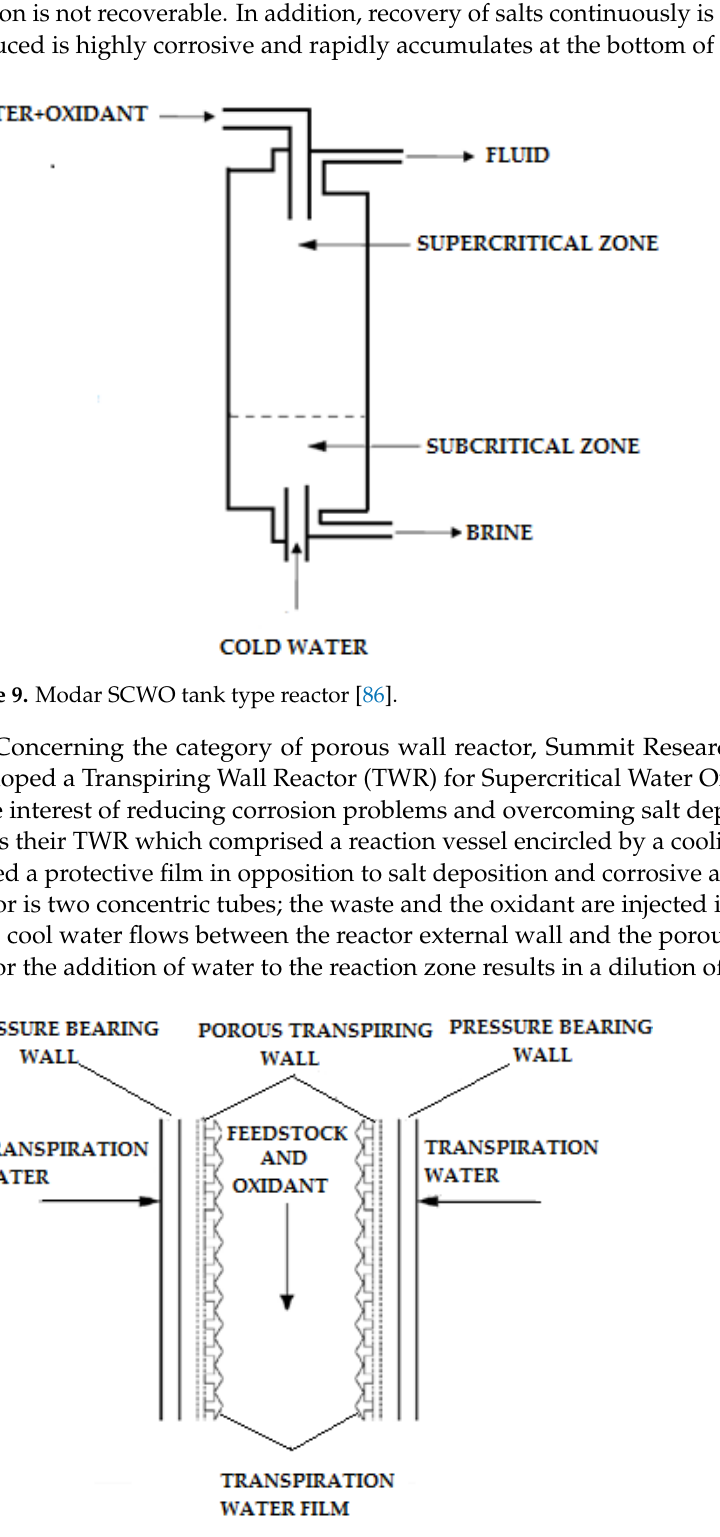
Figure 10. Transpiring wall porous reactor [36].